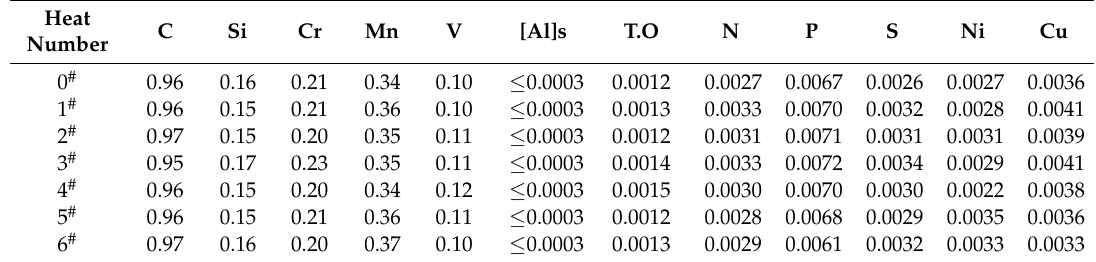
Table 2. Chemical composition of C96V saw wire steels (mass %).